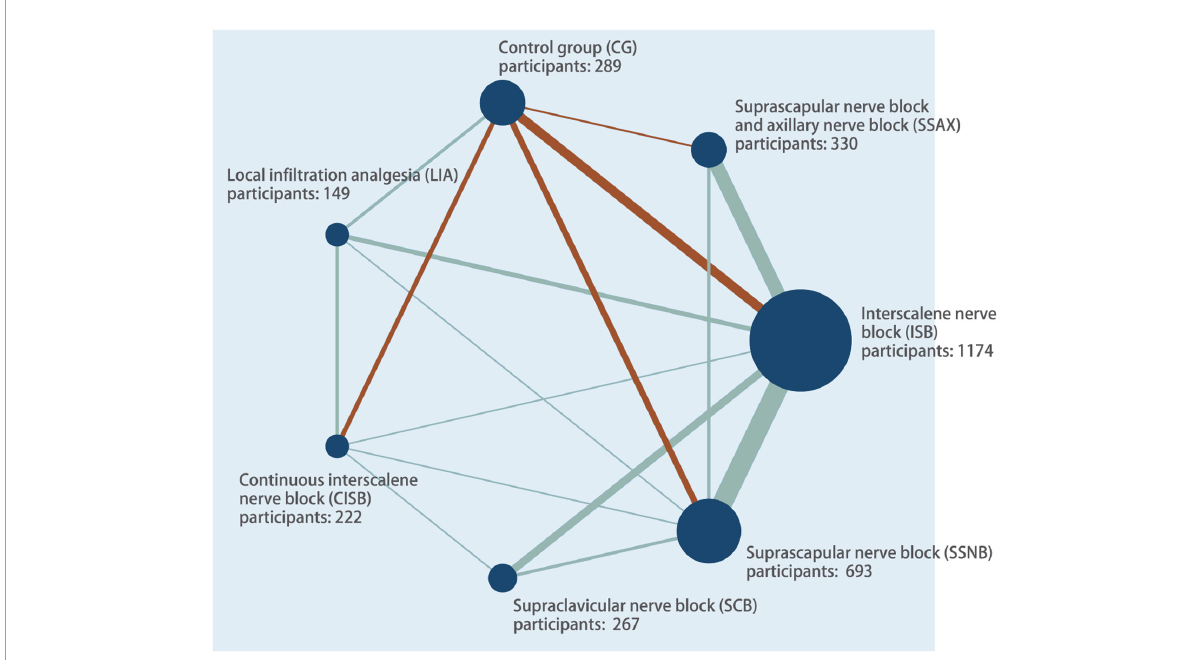
FIGURE2 Network plot of all evidence of all the trails. The network plot of the intervention network shows the comparison of the sample size to provide anesthesia for patients undergoing arthroscopic shoulder surgery. Each node represented a different method of prevention with size of the node depending on the number of patients who received the intervention directly. The nodes were connected by lines indicating direct relationships between interventions, with the thickness of the line depending on the amount of direct evidence supporting the